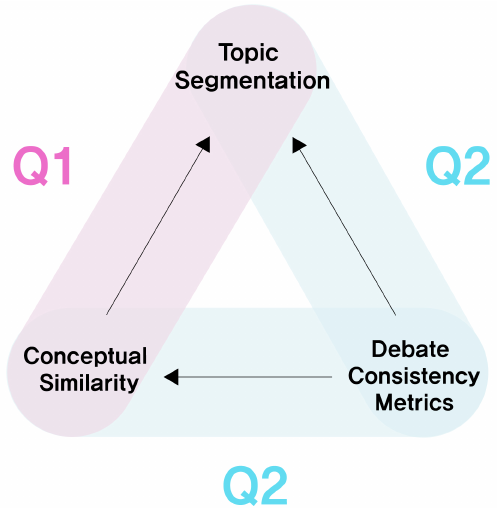
Figure 1. Two research questions Q1 and Q2. Q1 is whether conceptual similarity affects topic segmenta- tion. Q2 is whether debate consistency metrics affect conceptual similarity, and thus topic